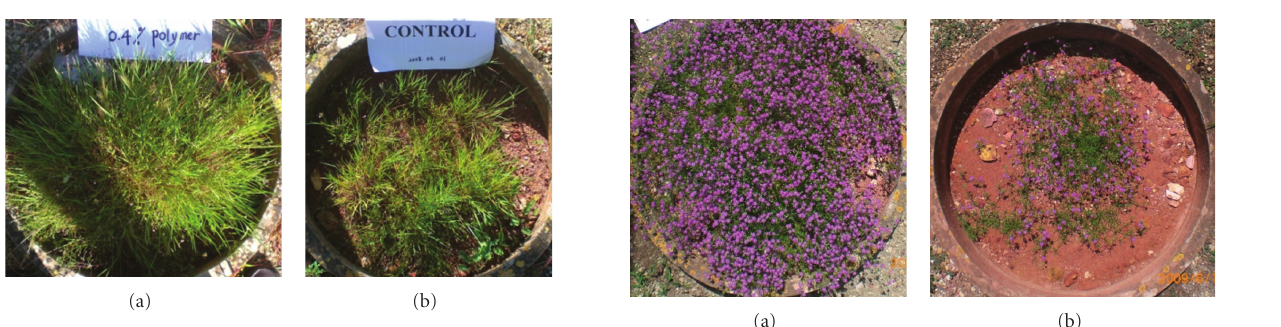
Figure 6: Growth of Spergularia purpurea in a soil derived from a pyrite mine. Mine soil received 0.3% shredded diapers per kg of soil (a) or was left unamended